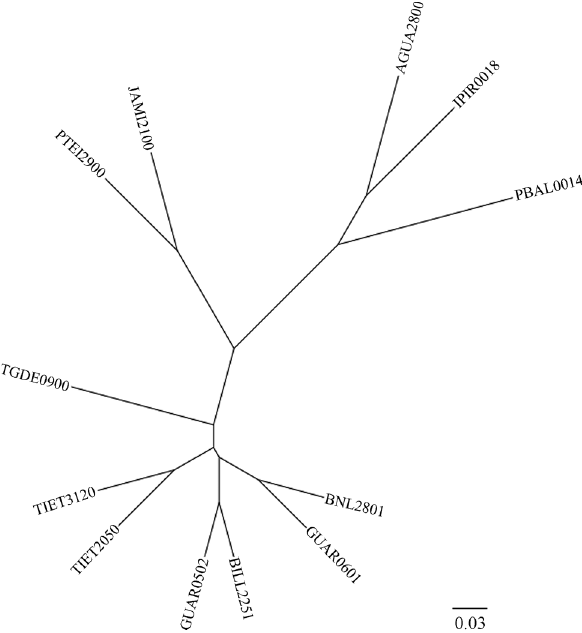
Figure3 - DendrogramobtainedbytheUPGMAclusteranalysismethod.